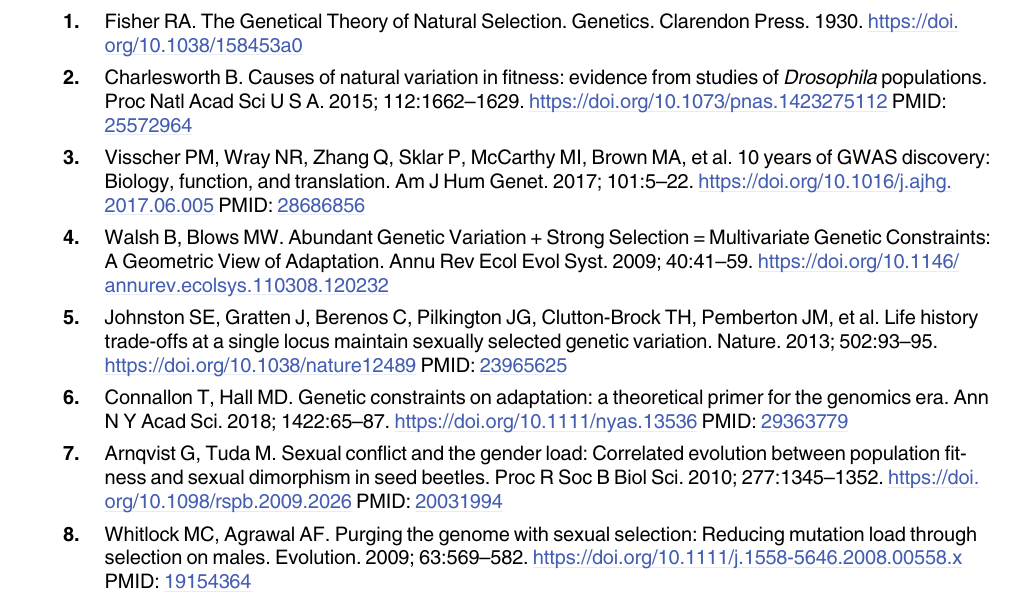
signals of sex differences in selection. Section E. Null model for unfolded reproductive F Section F. Correcting for sex-specific population structure. Section G. Sex differences in selec- tion and the relation between F and MAF. Section H. Associations between metrics of sex ST differences in selection and MAF. Section I. Associations between metrics of sex differences in selection and candidates for balancing